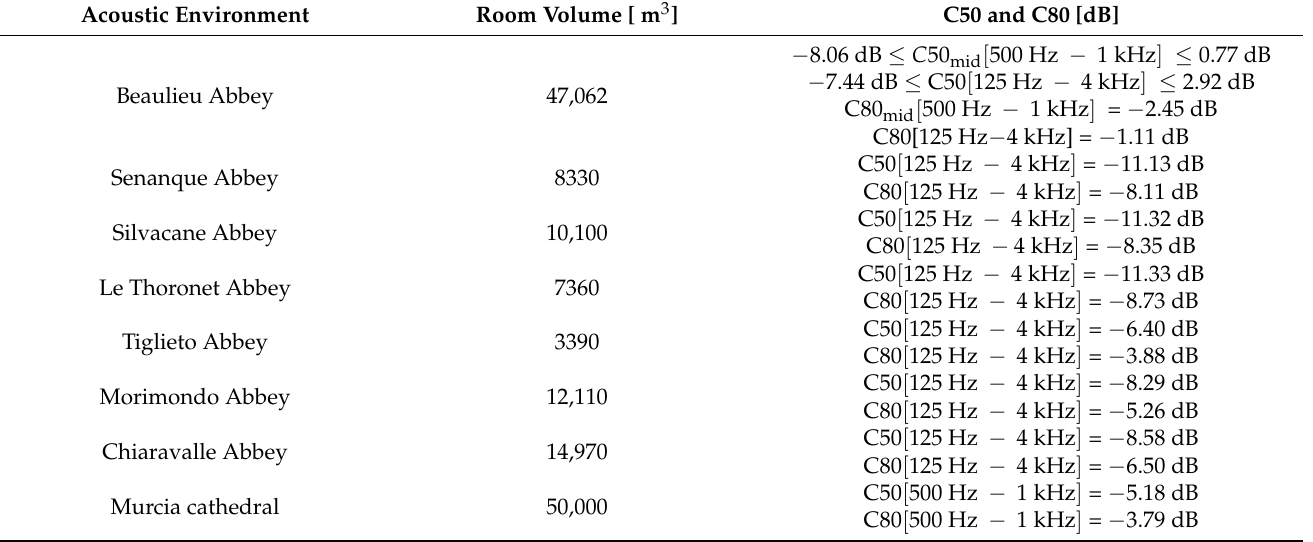
Table 8. Spatially and frequency averaged C50/C80 values